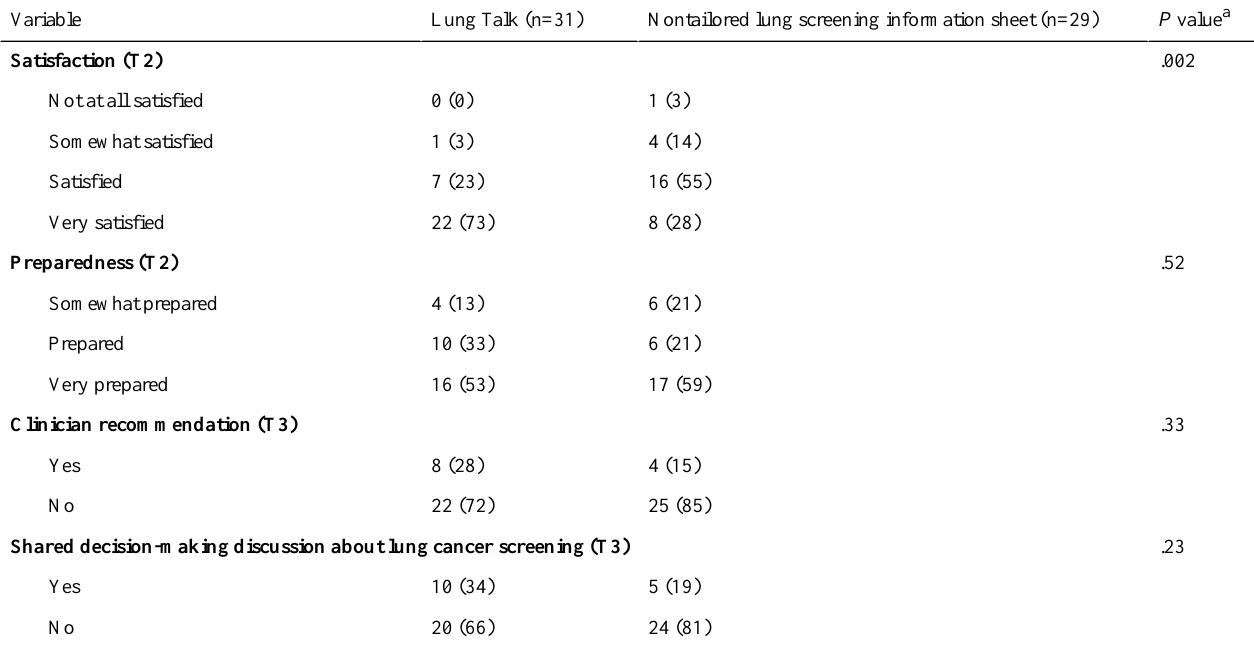
Table 5. User satisfaction, clinician recommendation, shared decision-making discussion by